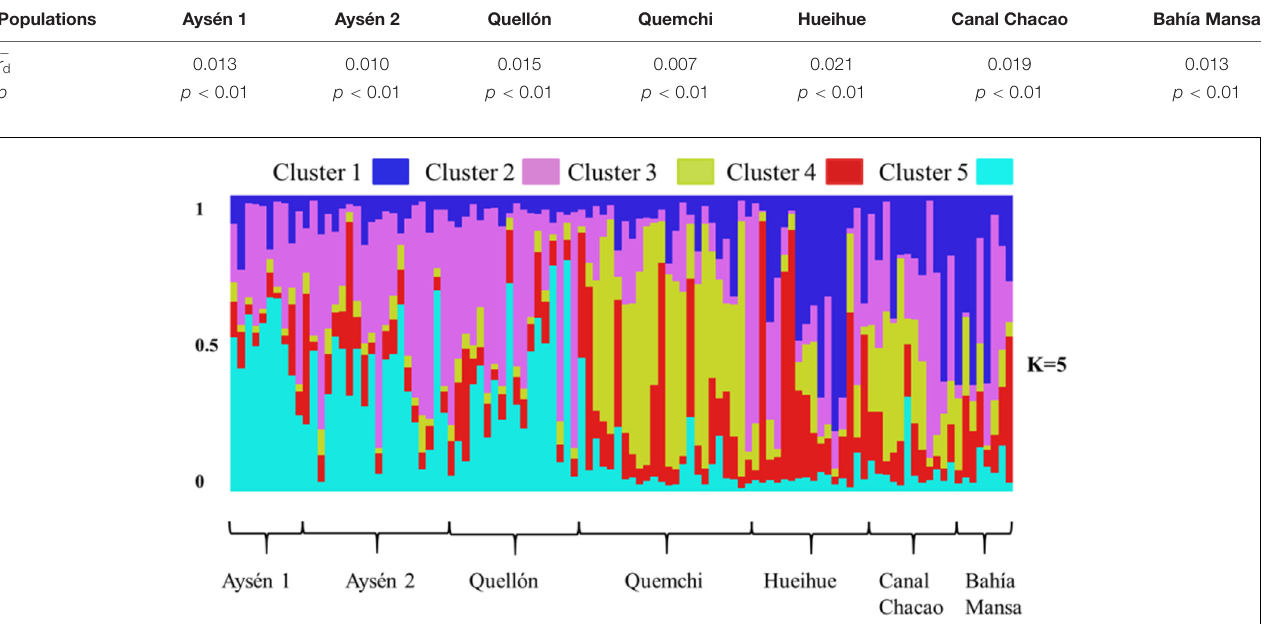
TABLE 4 | Multilocus linkage disequilibrium index